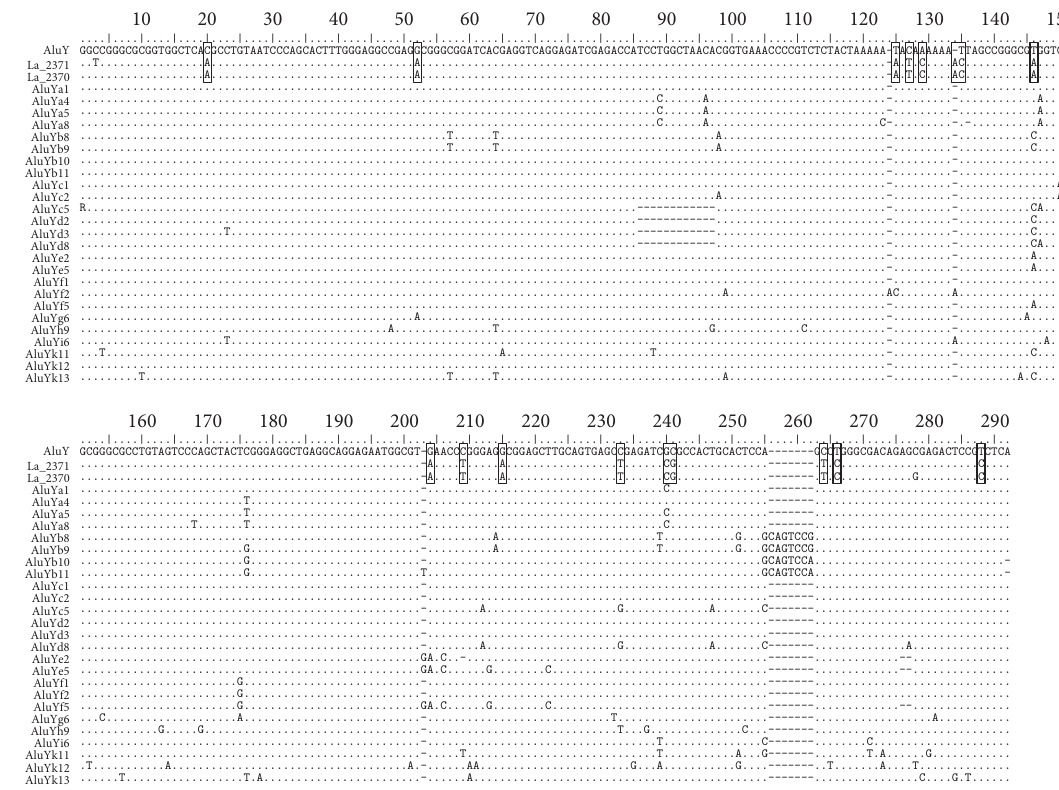
Figure 6: Sequence alignment of various primate AluY subfamilies. Various AluY subfamilies show the different diagnostic mutation sites. AluYl17 has seventeen diagnostic mutation sites. Open box is the diagnostic mutation of AluYl17 . Dots indicate the same sequences with consensus AluY sequence and dashes indicate